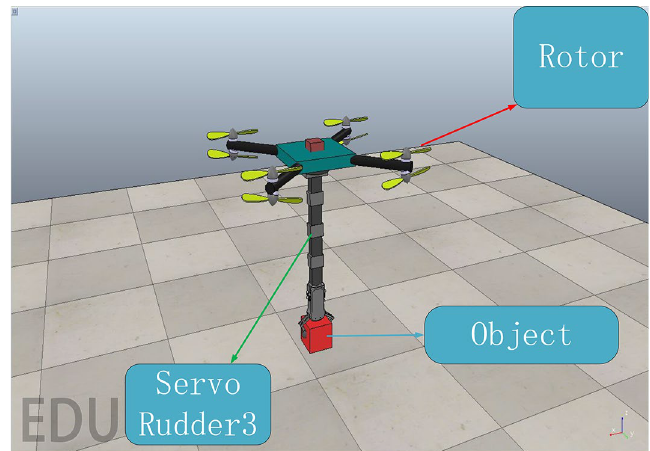
Figure 8. The demonstration of virtual experiment in CoppeliaSim.